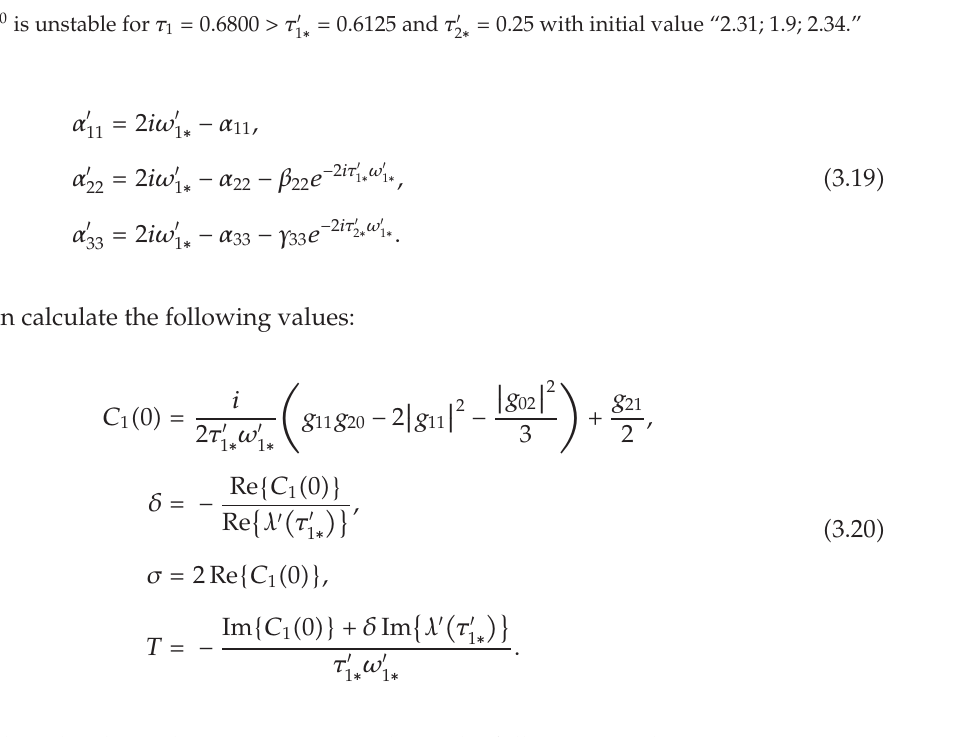
Figure 8: E 0 is unstable for τ 1 (cid:6) 0 . 6800 > τ (cid:7)